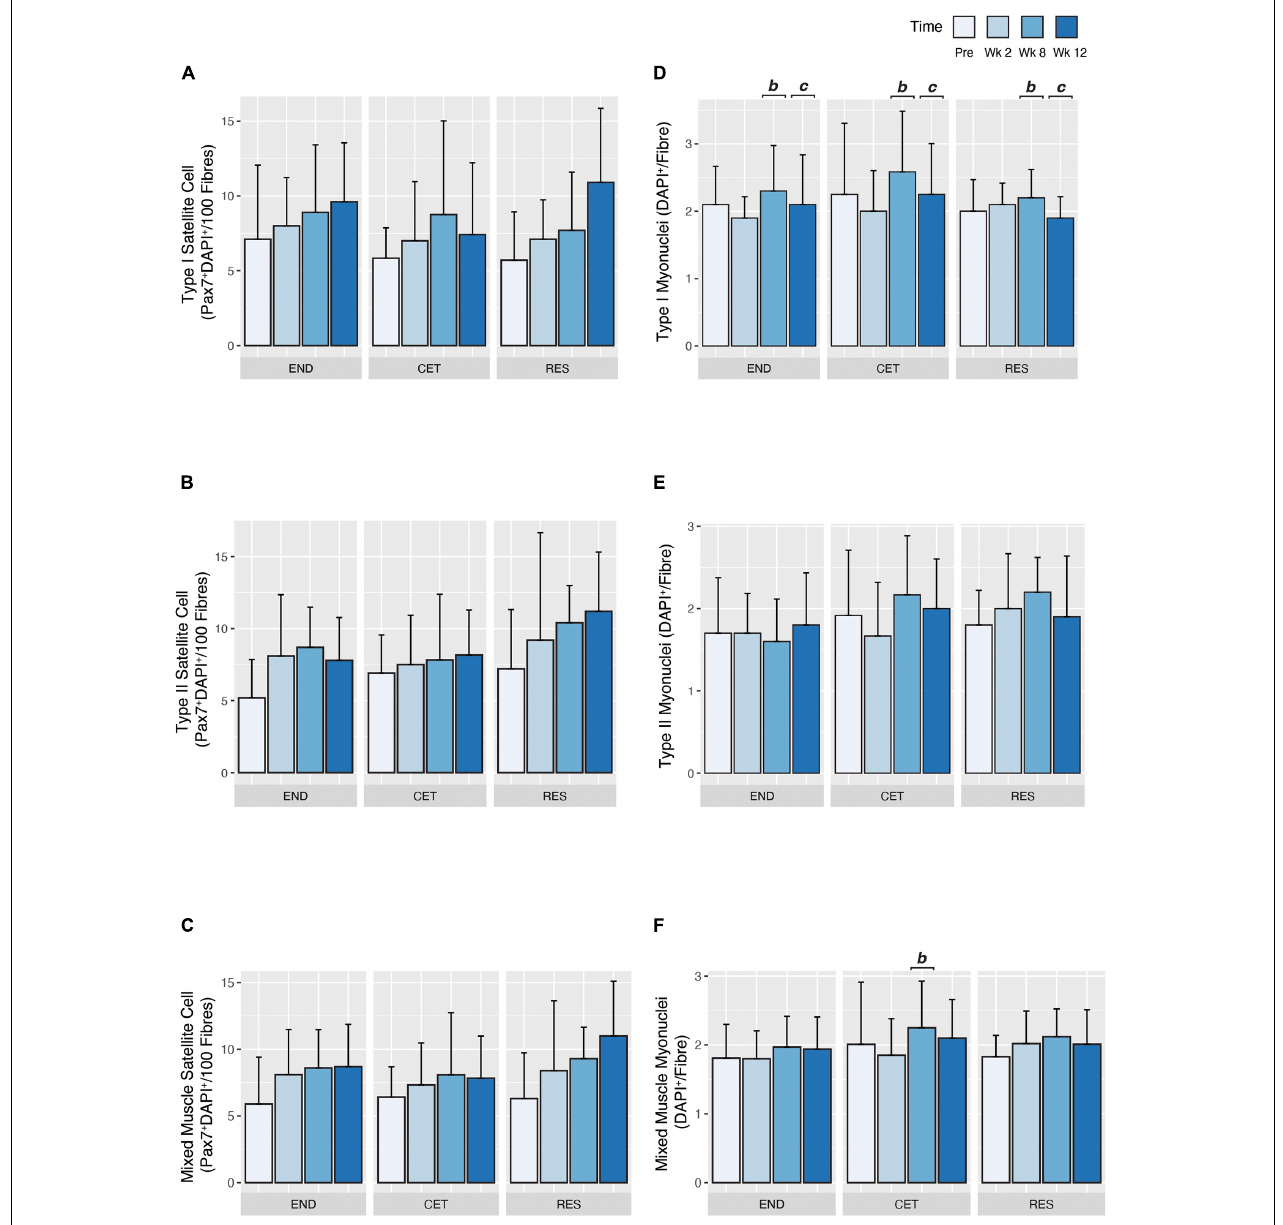
FIGURE 5 | Fibre type-specific satellite cell (A–C) and myonuclear (D–F) expansion in response to endurance (END, n = 10), resistance (RES; n = 10), or concurrent (CET; n = 12) training. Change in myosin heavy chain type I (A) , myosin heavy chain type II (B) , and mixed (C) myofibre satellite cell content. Change in myosin heavy chain type I (D) , myosin heavy chain type II (E) , and mixed (F) myofibre myonuclear content. b, significantly different from week 2 time point ( P < 0.05); c, significantly different from week 8 time point ( P < 0.05). Values are presented as Mean ±